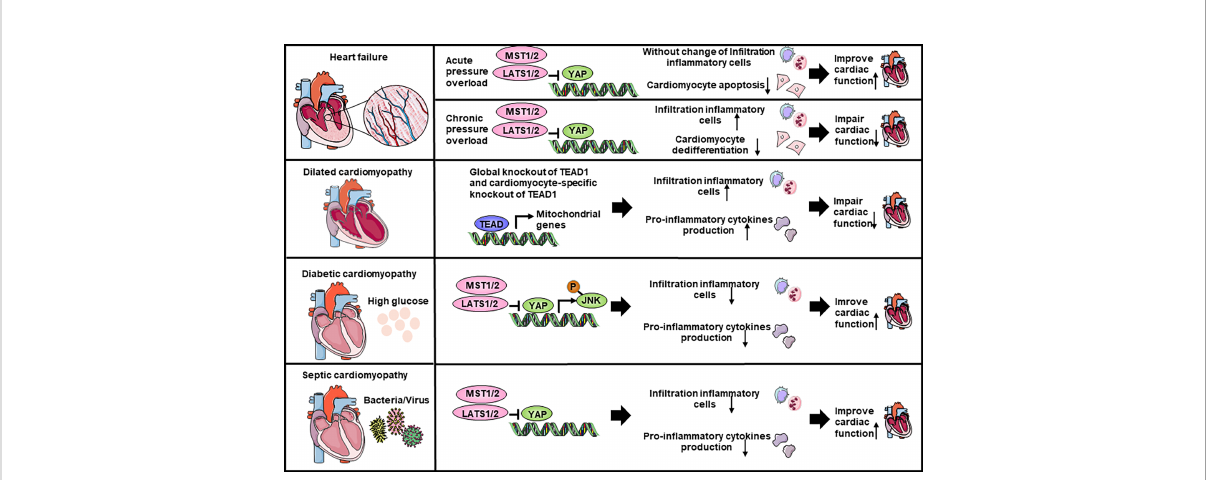
FIGURE 3 The Hippo-YAP pathway regulate the in fl ammation response in heart failure and cardiomyopathy. YAP increases the accumulation of in fl ammatory cells and impairs cardiac function in chronic pressure overload while hardly affects the accumulation of in fl ammatory cells in acute pressure overload. In dilated cardiomyopathy, global knockout of Tead1 and cardiomyocyte-speci fi c knockout of Tead1 both can increase in fl ammatory cells in fi ltration and pro-in fl ammatory cytokines production to impair heart function. Both in diabetic cardiomyopathy and septic cardiomyopathy, YAP is able to inhibit in fl ammatory cells recruitment and pro-in fl ammatory cytokines production, thereby improve heart function. JNK, c-Jun N-terminal